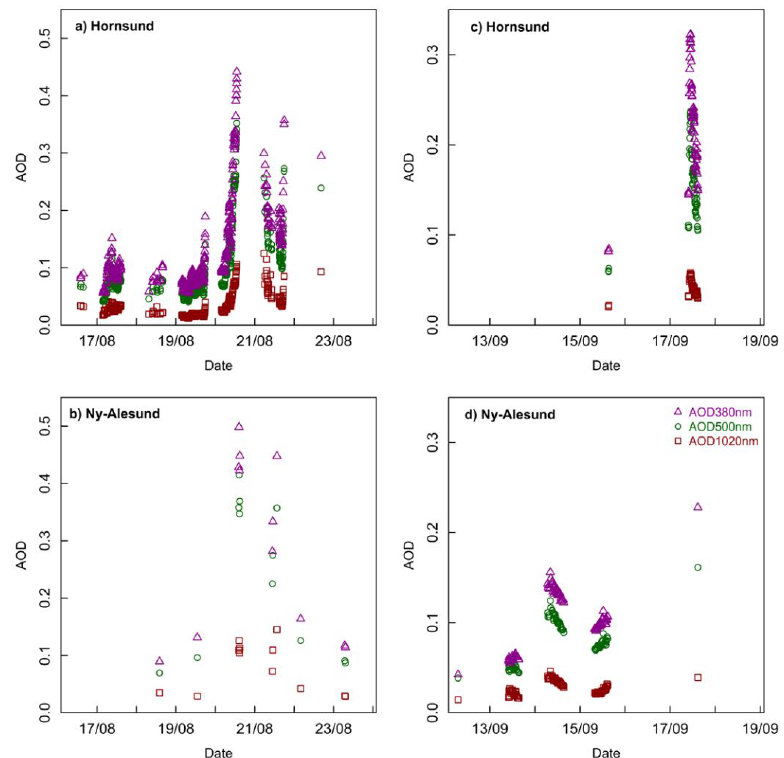
Figure 7. AOD time series retrievals from Hybrid Sky Scan inversions [94] during the summer 2017 biomass burning (BB) events at two AERONET sites in Spitsbergen. ( a , b ) depict AOD values measured in August 2017 in Hornsund and Ny-Ålesund, respectively. ( c , d ) show AOD values measured in September 2017 in Hornsund and Ny-Ålesund, respectively.